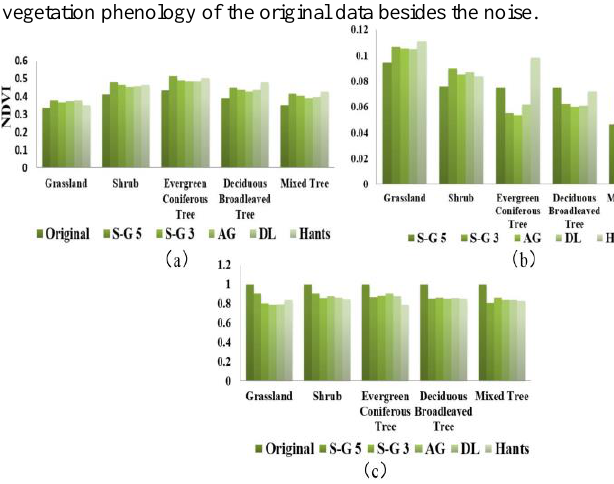
Fig. 4: a) Mean values of the original and filtered NDVI time series; b) MAE of the filtered NDVI time series; c) Correlation coefficient of the